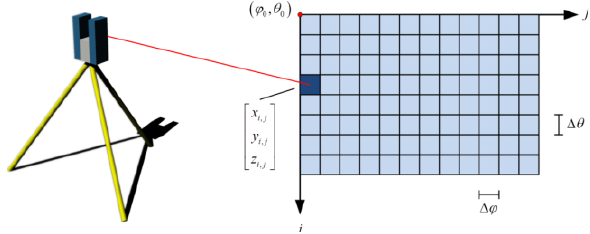
Figure 2. Generation of a 2D-representation